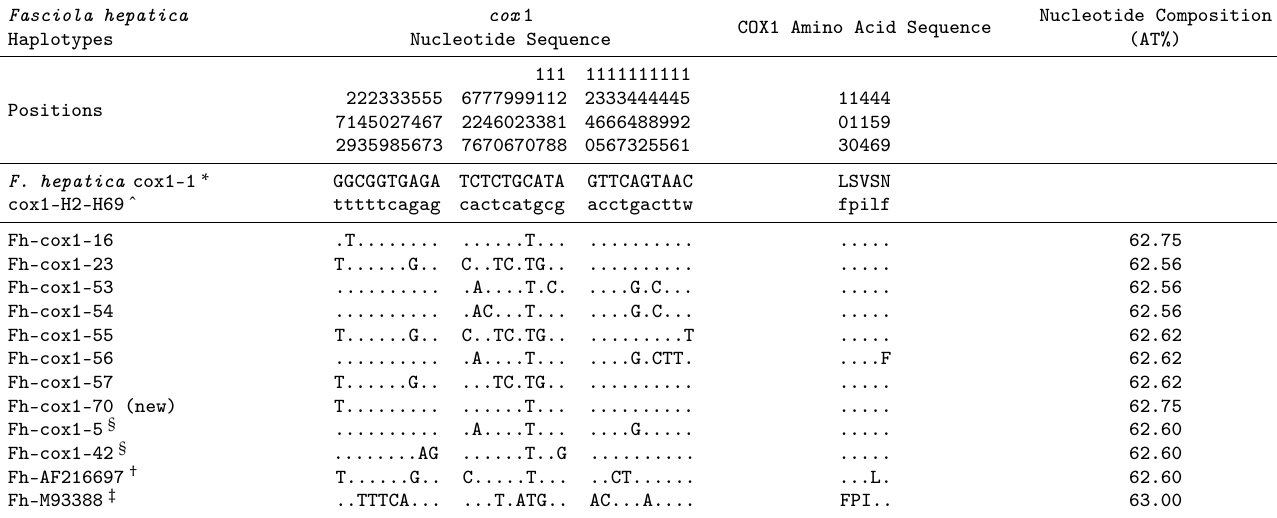
Table 5. Nucleotide sequence (1533 bp-long) and protein sequence (511 aa-long) of the complete mtDNA cox 1 gene of Fasciola hepatica populations studied from Ecuador compared to other haplotypes of the same species. Positions = numbers (to be read in vertical) refer to variable positions obtained in the alignment made with MEGA 7.0; . = identical. Fasciola hepatica cox 1 COX1 Amino Acid Sequence Haplotypes Nucleotide Sequence